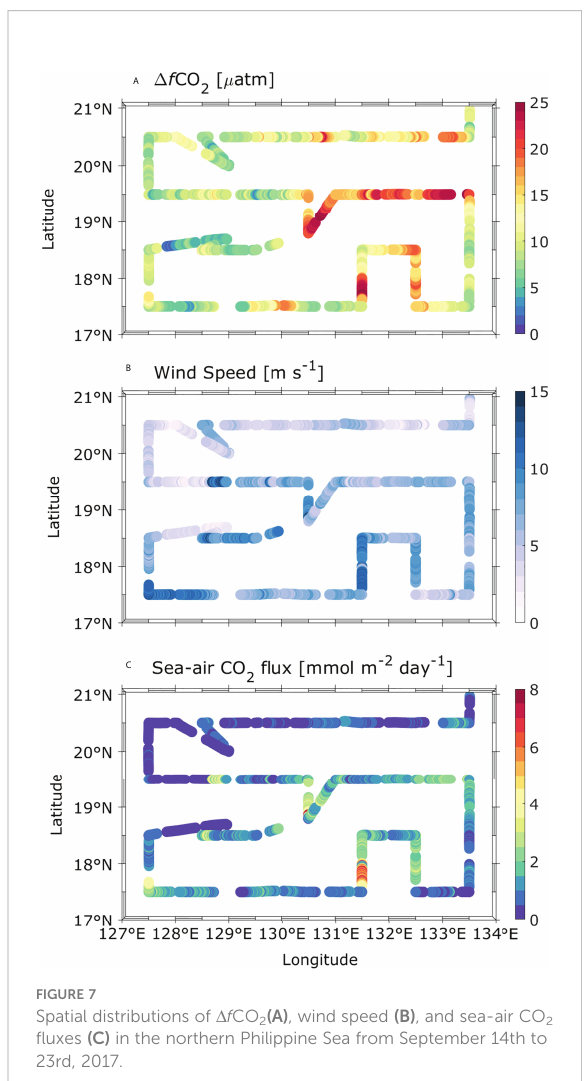
FIGURE 7 Spatial distributions of D f CO 2 (A) , wind speed (B) , and sea-air CO 2 fl uxes (C) in the northern Philippine Sea from September 14th to 23rd,